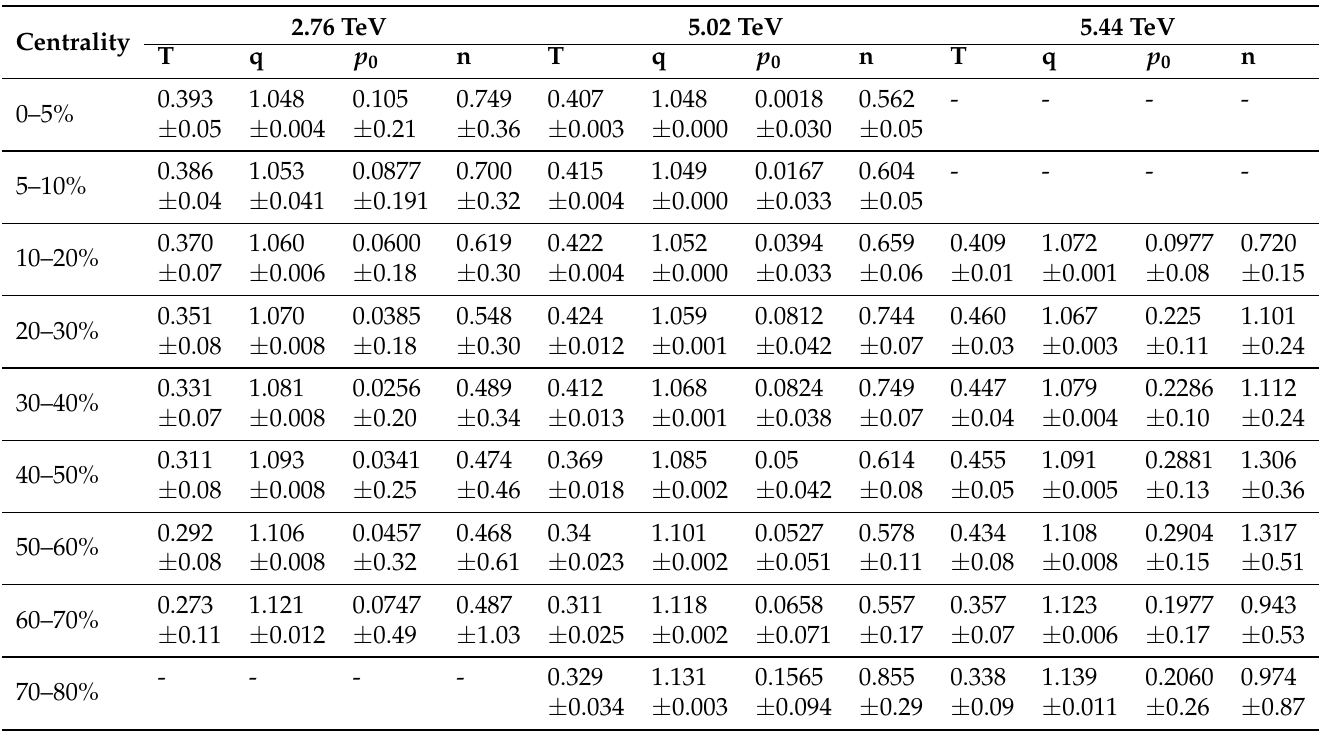
Table 1. Numerical values of the fit parameters T (GeV), q , p 0 (GeV/c) and n obtained by fitting the experimental data of p T -spectra fitted with the unified formalism Equation